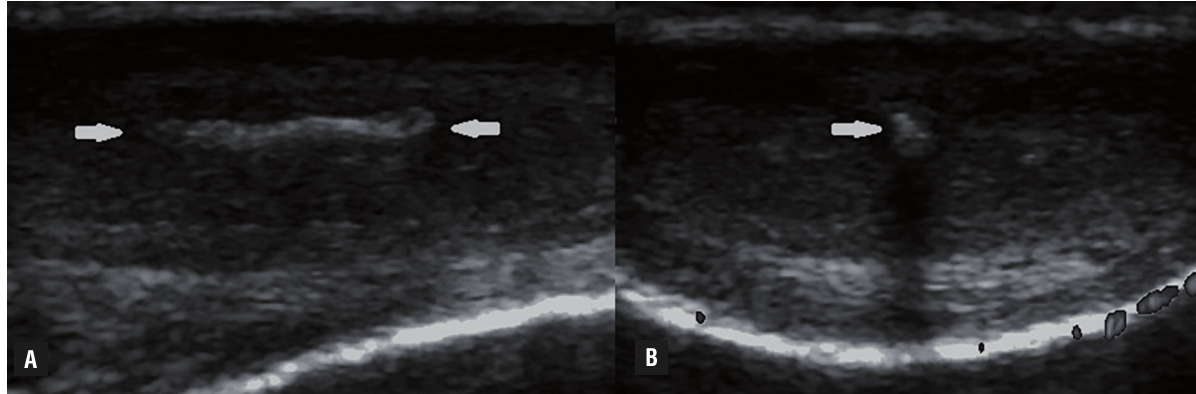
arrow).Figure 1 - Longitudinal (A) and transverse (B) US images obtained along the ventral aspect of the penis show a hyperechoic thickening of the intercavernosus septum with acoustic shadow (white arrows).